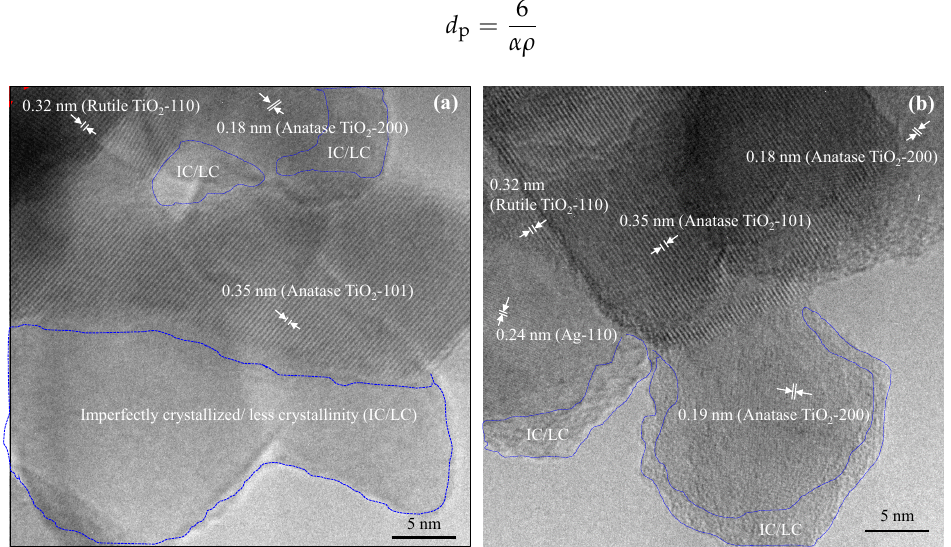
Figure 5. TEM images of the Ag-TiO 2 nanocomposite films annealed at 600 ºC with heating rates of 5 ºC/min (a) and 60 ºC/min (b). The holding time for annealing was maintained at 12 h.